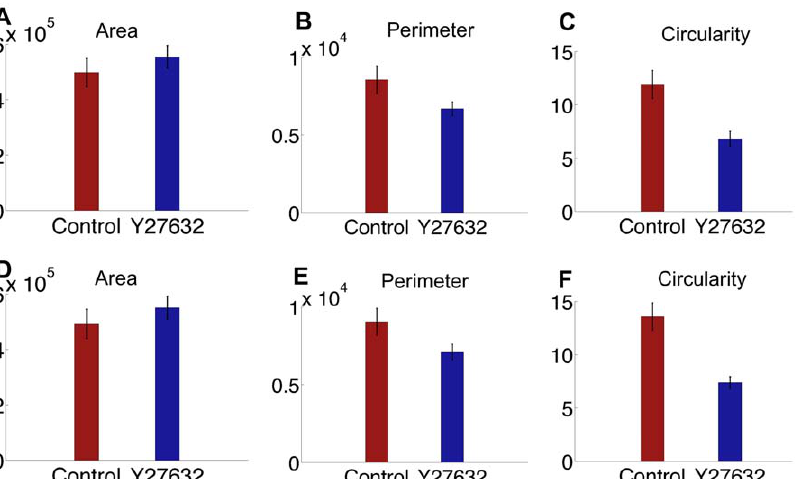
Figure 3. Direct validations of cell-graph features using standard image analysis methods. Plots of (a) area, (b) perimeter and (c) circularity from images using conventional image analysis methods and plots of cell-graph-derived raw data pertaining to (d) area, (e) perimeter and (f) circularity are shown. Control refers to untreated epithelium and Y27632 refers to the ROCK inhibitor treatment. The same trends for control vs ROCK inhibitor treatment were observed for the features obtained using image analysis and cell-graphs. The percent differences between the conventional image analysis and our image segmentation technique are found to be 1.16% and 0.73% for the area; 5.66% and 5.94% for the perimeter; 11.0532 and 16.1463 for the circularity of the control and ROCK inhibitor-treated samples,